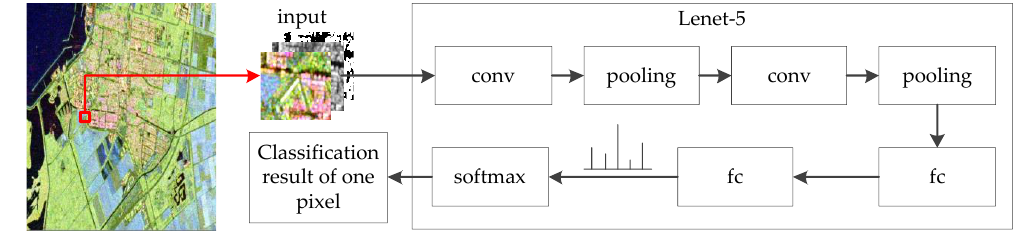
Figure 1. PolSAR image classification architecture based on